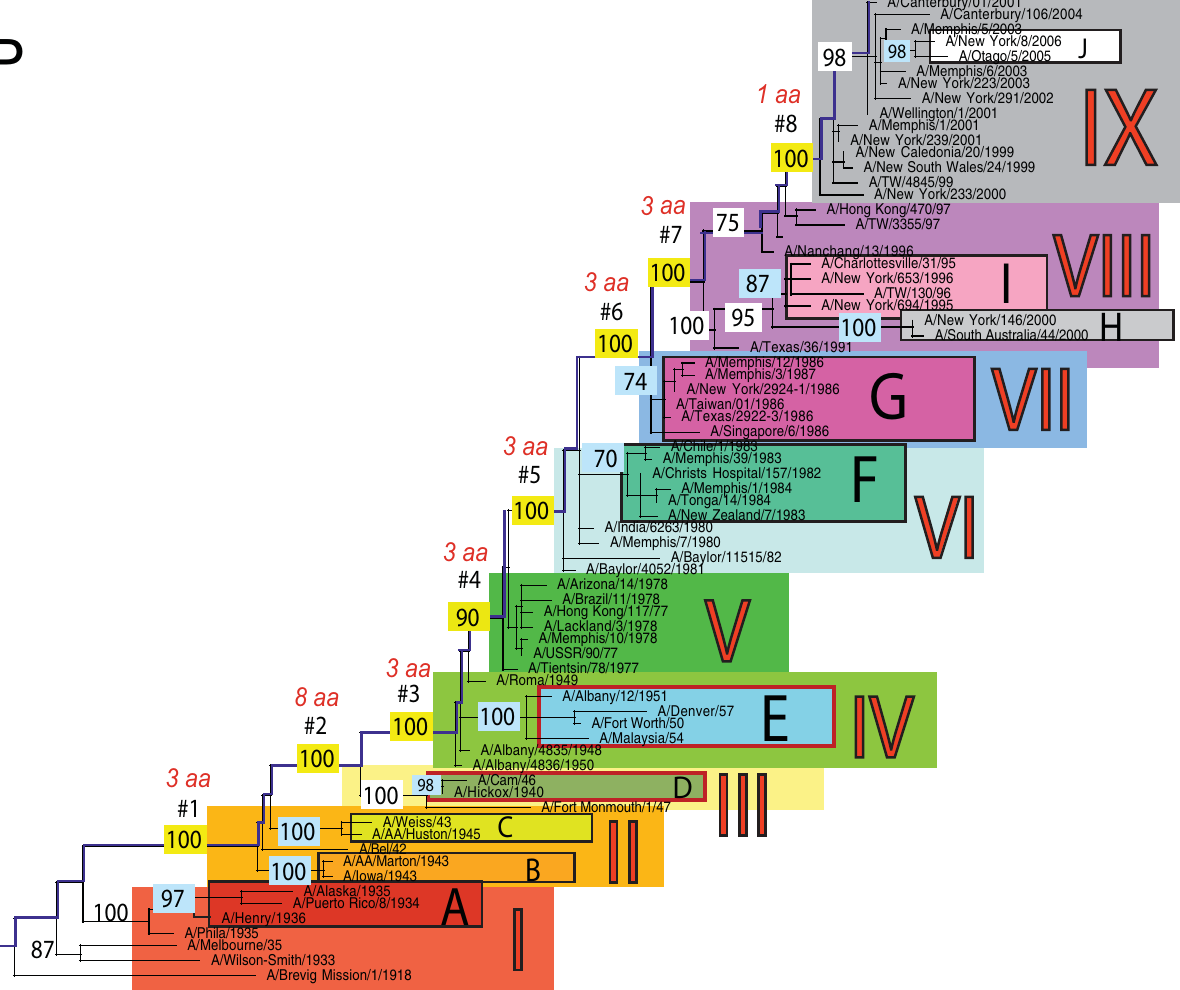
Figure 5. Phylogenetic relationships of the NP gene of A/H1N1 influenza viruses (n=71) sampled globally from 1918–2006, estimated using ML. Rooting, scale, and color scheme are the same as those used in Figure 1.